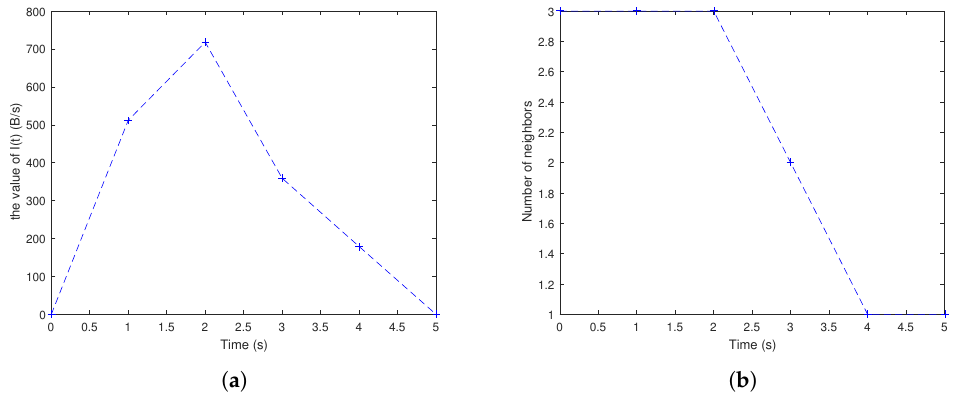
Figure 3. Parameters of the node: ( a ) effective information traffic; ( b ) number of